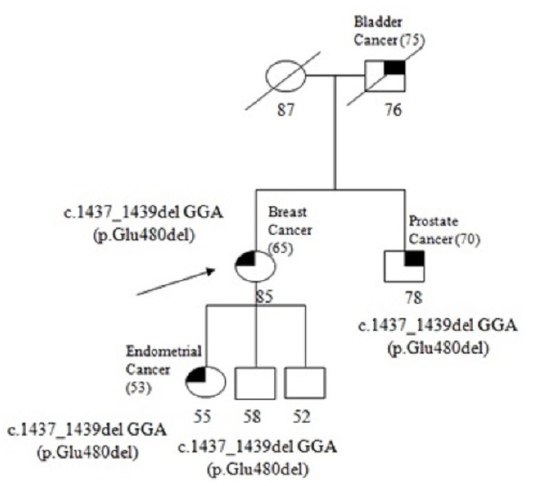
Figure 2. Pedigree of the proband carrying the monoallelic MUTYH mutation c.1437_1439del GGA (p.Glu480del). The ages at diagnosis are indicated in brackets.